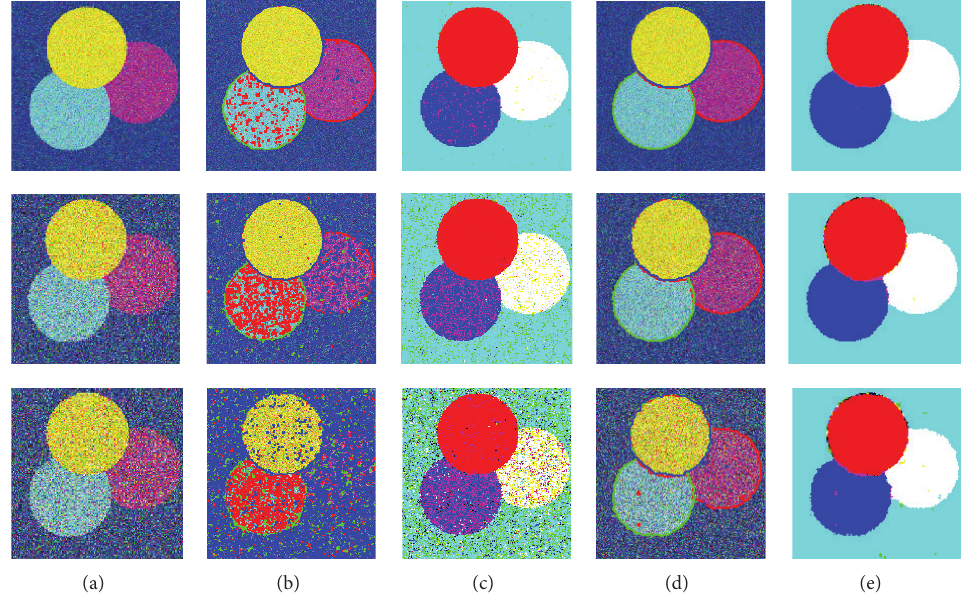
Figure 7: Results for a synthetic image added with Gaussian noise with deviations 0.01, 0.03, and 0.08, respectively. (a) Original noisy images; (b) the final contours of the STP-CV model; (c) the segmentation results labeled with different colors of the STP-CV model; (d) the final contours of the proposed model; (e) segmentation results labeled with different colors of the proposed model.